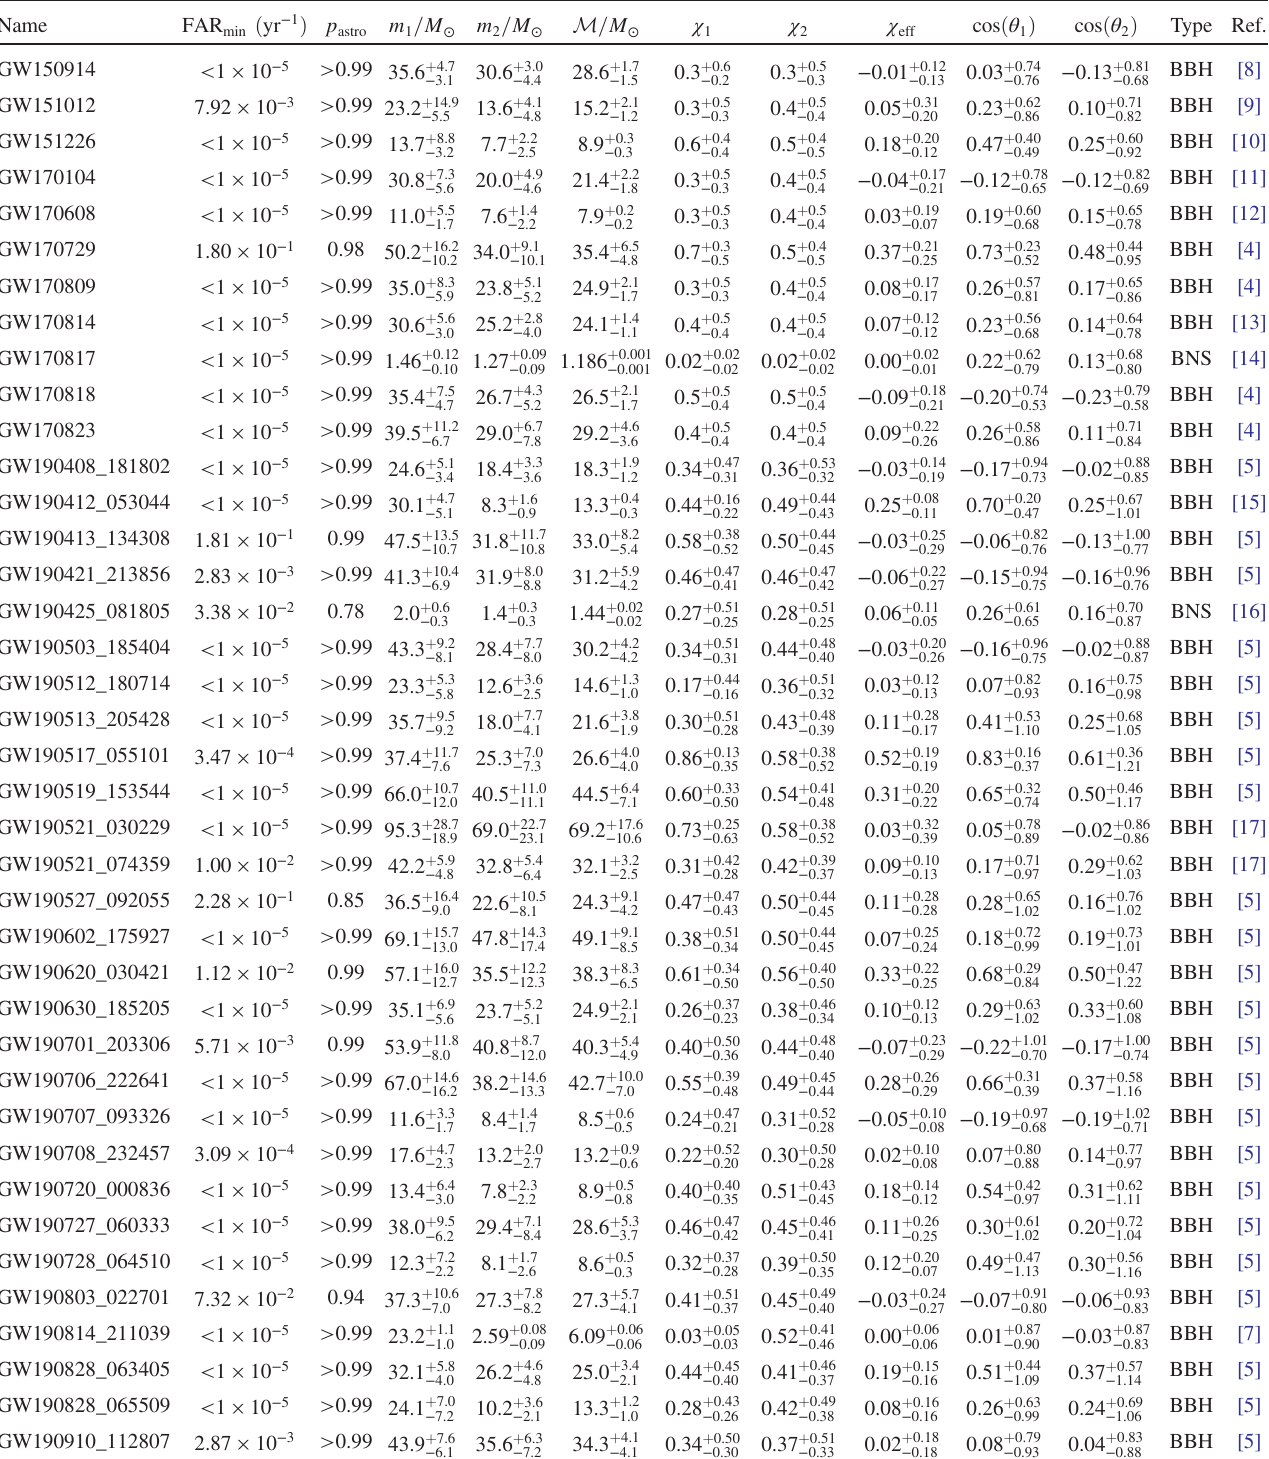
TABLE I. A table of GW events that meet the criteria for inclusion in this work. Events are separated by a horizontal line into